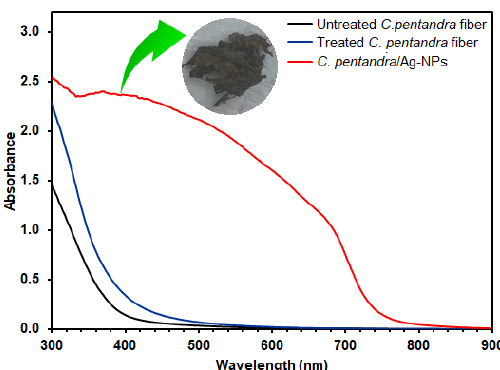
Figure 7. UV–vis spectra of untreated C. pentandra fiber, treated C. pentandra fiber and C. pentandra /Ag-NPs.